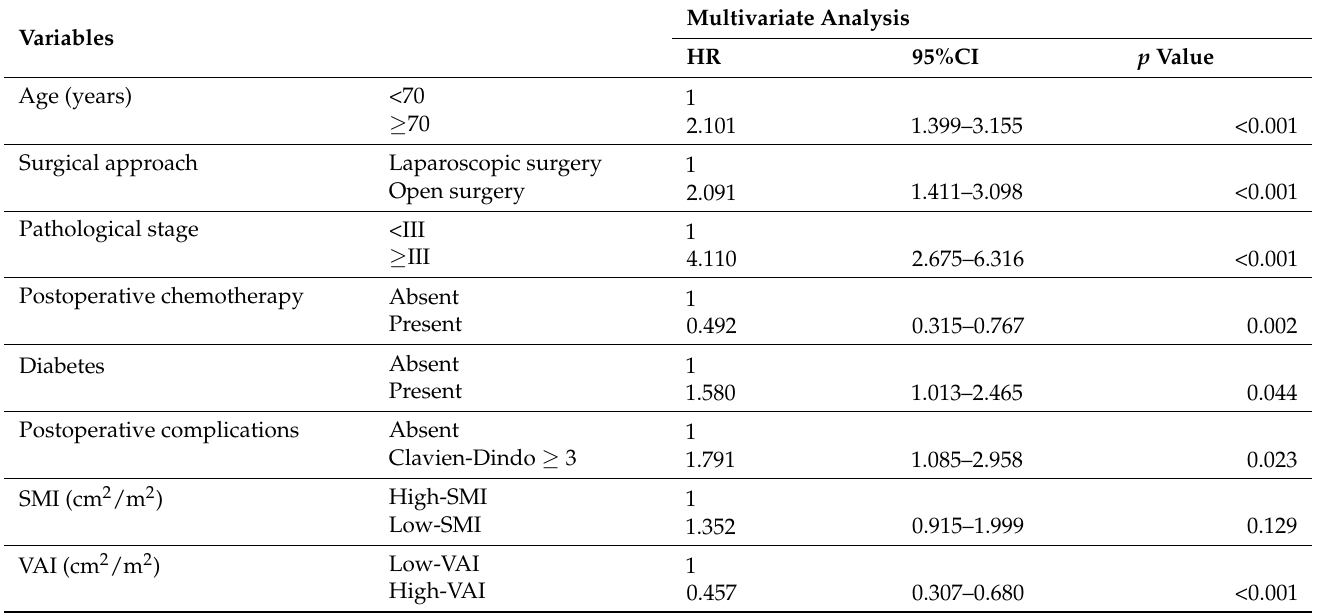
Table 3. Result of multivariate analysis of prognostic factors for overall